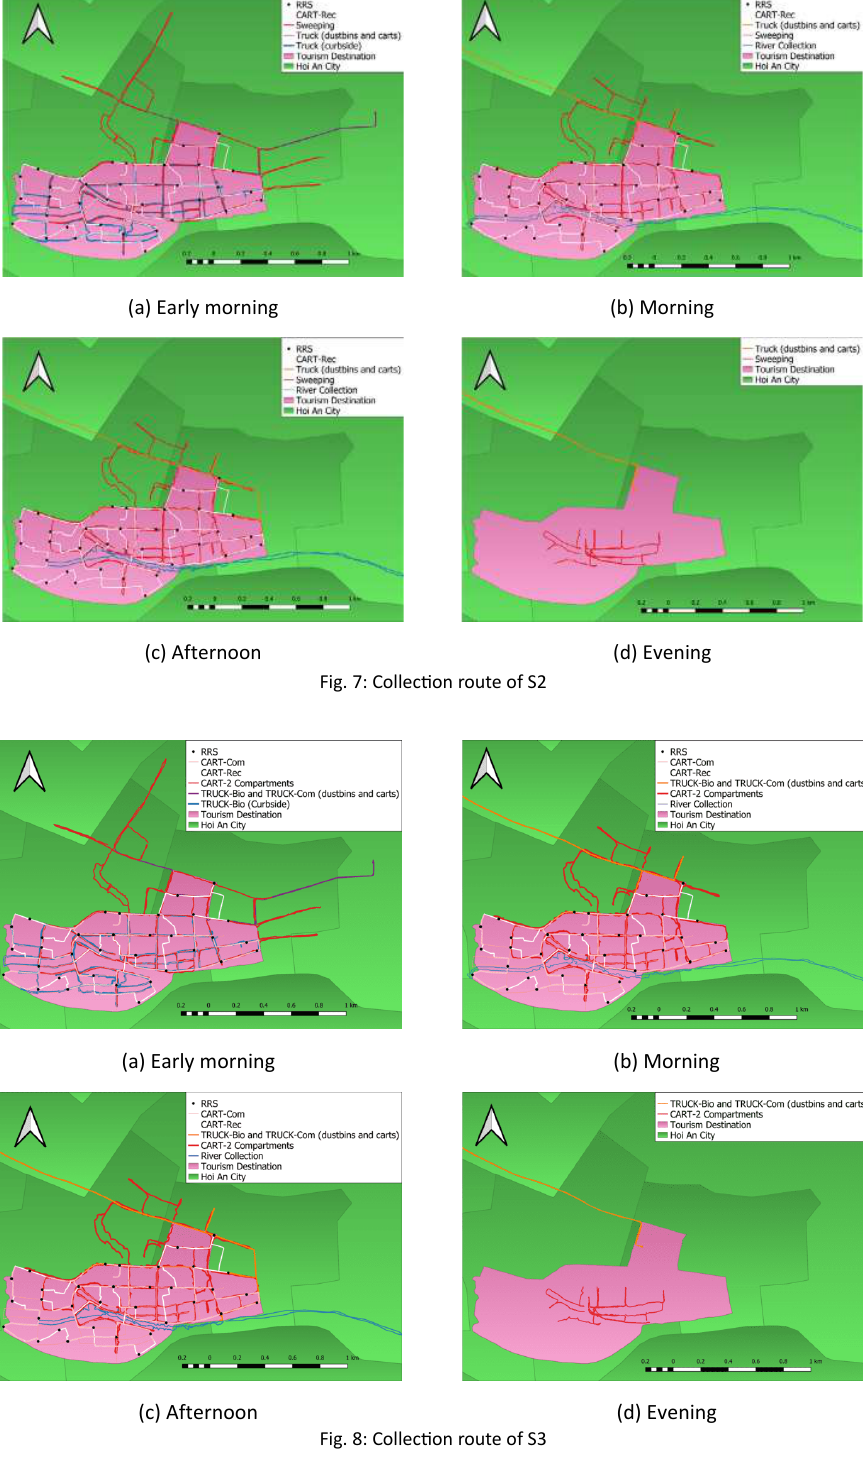
Fig. 8: Collection route of S3